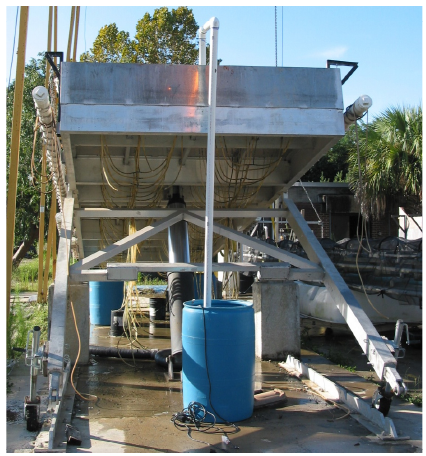
Figure 3. Influent delivery system.